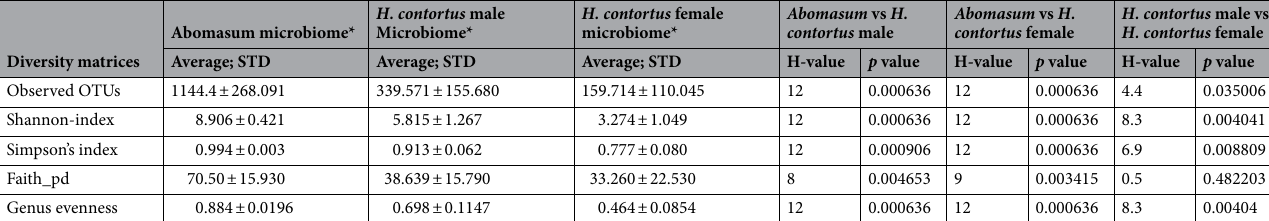
Table 1. Overview of alpha diversity metrics for the adult male, adult female H. contortus and abomasum content microbiome. P values were calculated using Kruskal–Wallis test. The level of significance was determined at P < 0.05. * Data represent average and standard deviation (STD) values from pooled